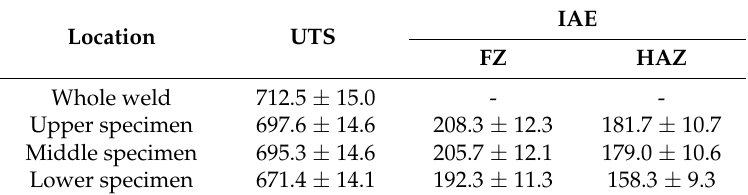
Table 3. UTS and IAE of different parts within the weld. FZ: fusion zone Location